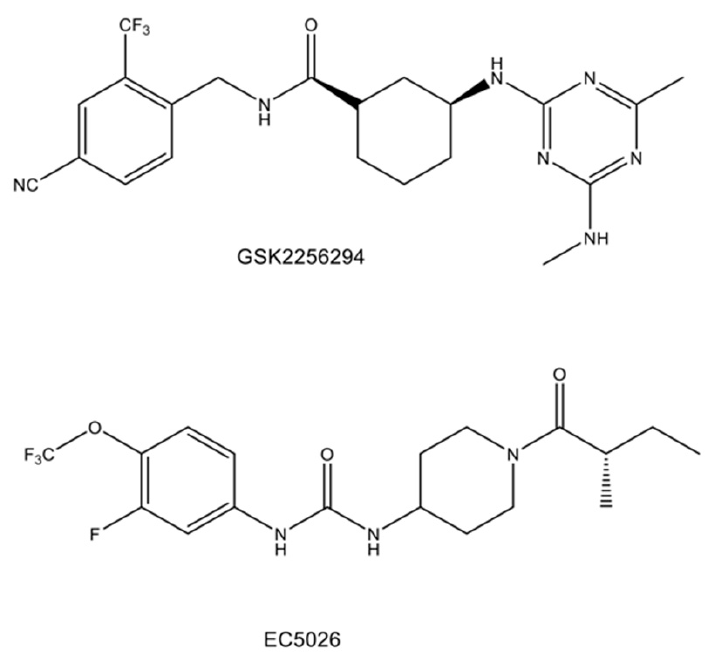
Figure 4. Chemical structure of GSK2256294 and EC5026 for human use.